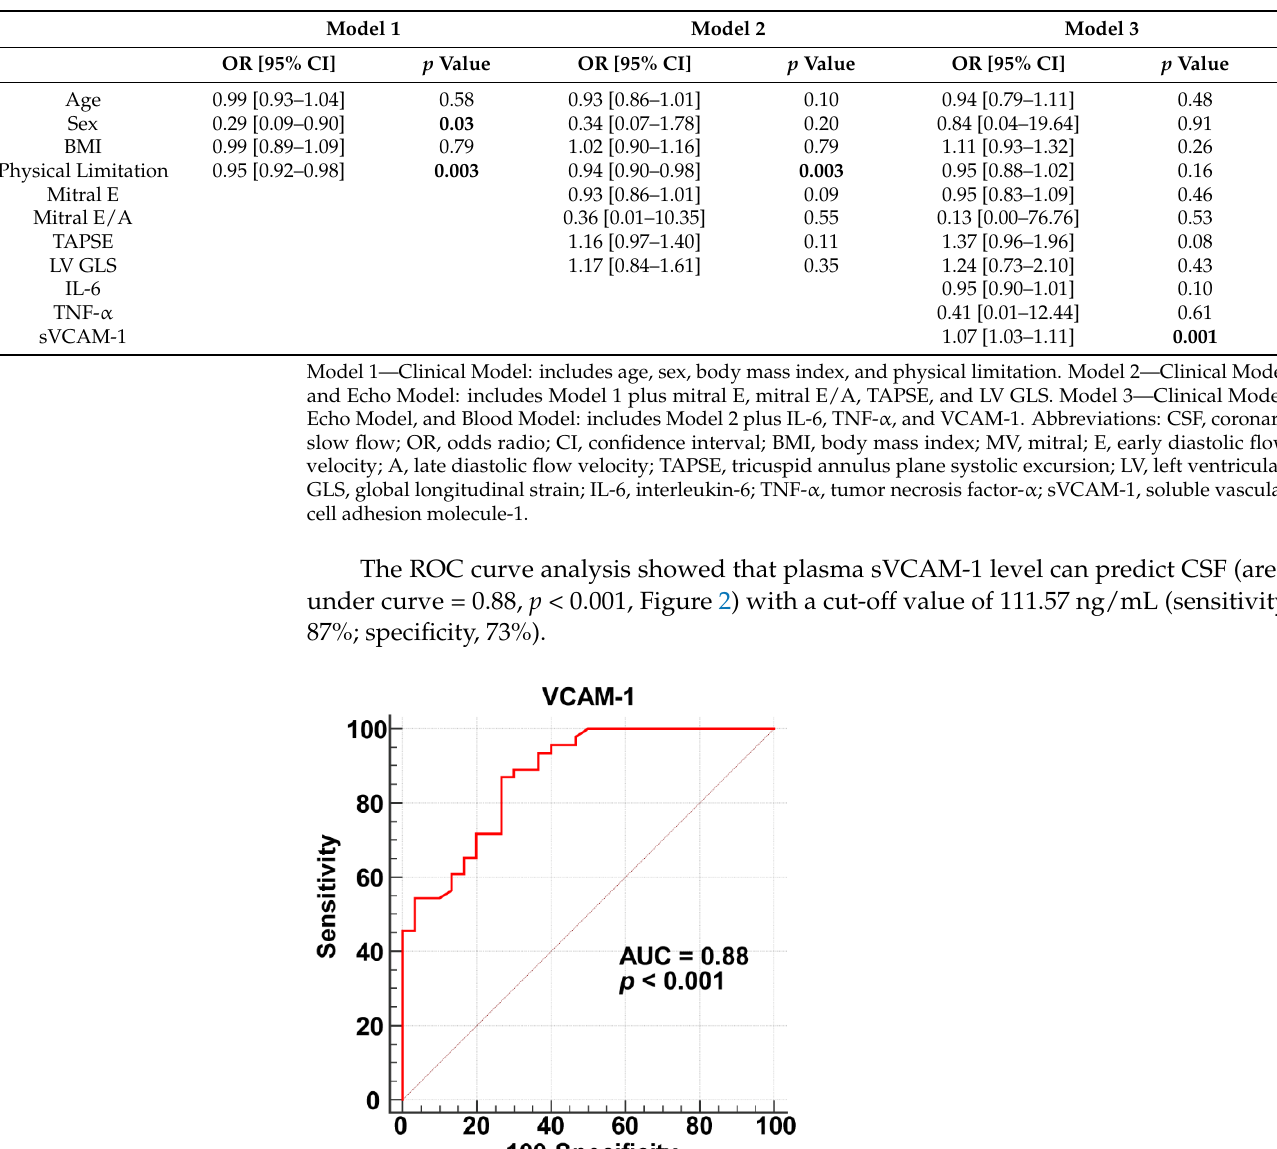
Table 5. Logistic regression analysis for CSF.